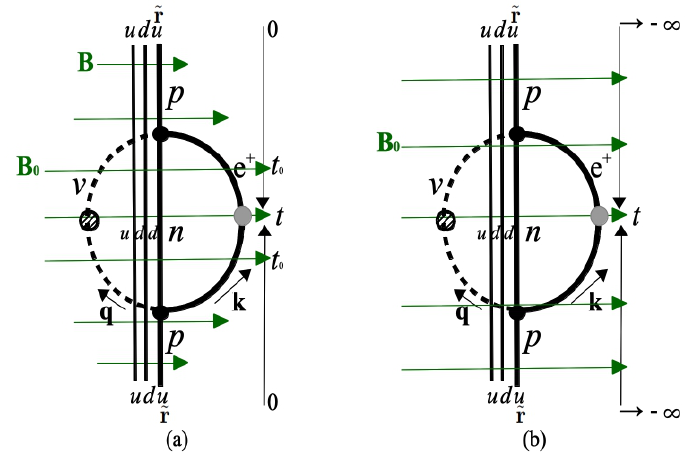
Figure 1 . (a) Diagrammatic representation of h ( K + Q (cid:23) )( t ) i at order W 2 considering the time e + evolution of B . Time runs along the vertical. The magnetic (cid:12)eld increases from 0 at time 0 to B 0 at t 0 . Black circles depict vertex operators, W . Kinetic momentum operators of neutrinos (dashed circle) and positrons (grey circle) apply at the observation time t & t 0 . (b) Diagrammatic representation of h K + Q (cid:23) i B according to eqs. (3.1) and (3.3) in the adiabatic approximation. e + 0 The value of the magnetic (cid:12)eld remains constant at B 0 , and the asymptotic state in the far past is j (cid:8) i B given in eq. 0